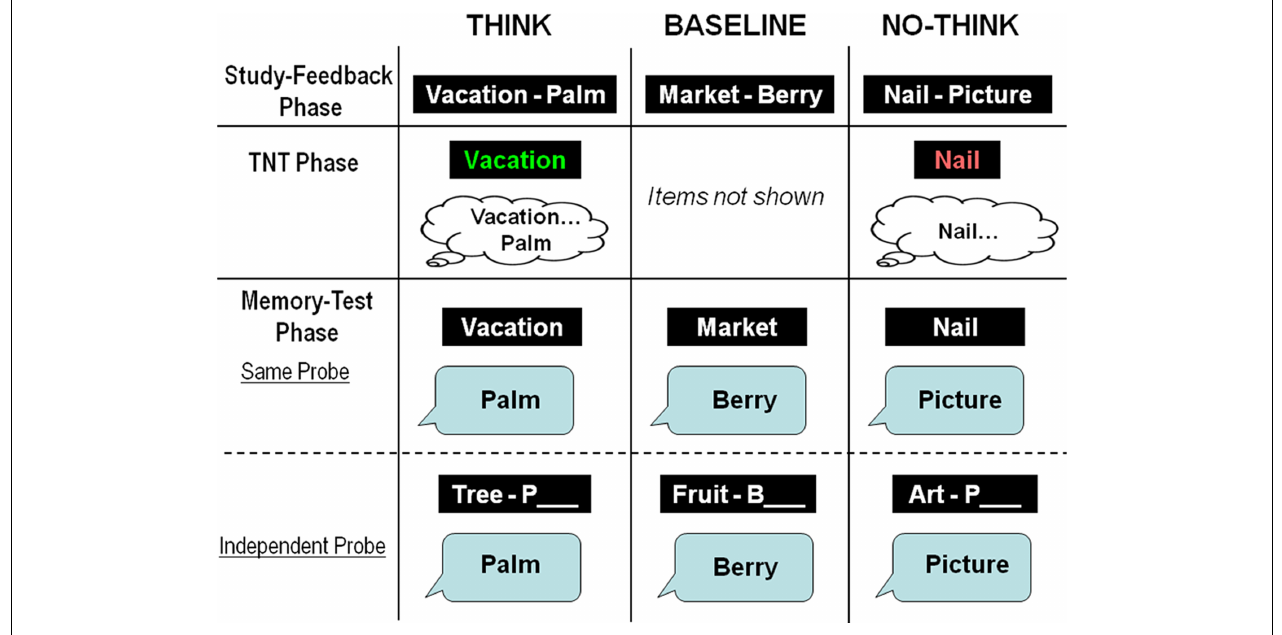
FIGURE 1 | Depiction of the three main phases of the TNT procedure: Study-feedback phase, TNT phase, and memory test phase (SP and